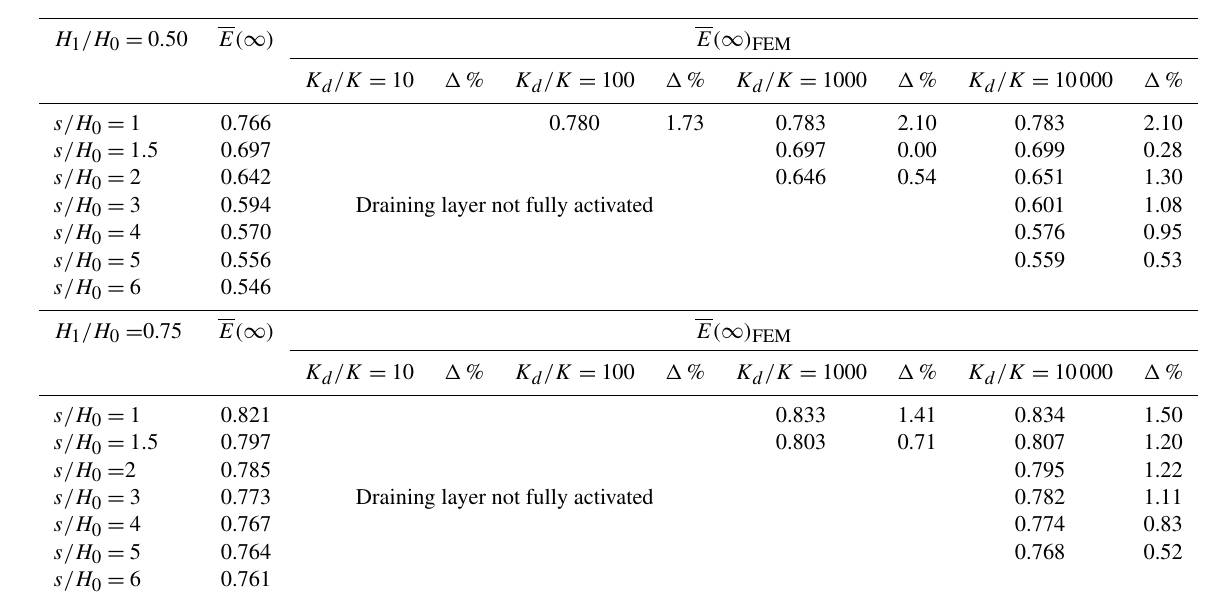
Table 2. Comparison among steady-state efficiency values computed by Eq. (8), E( ∞ ) , and FEM analyses, E( ∞ ) FEM · (cid:12) (cid:12) (cid:18) (cid:12) (cid:12) E( ∞ ) FEM − E( ∞ ) (cid:49) = (cid:12) E( ∞ ) FEM (cid:12)